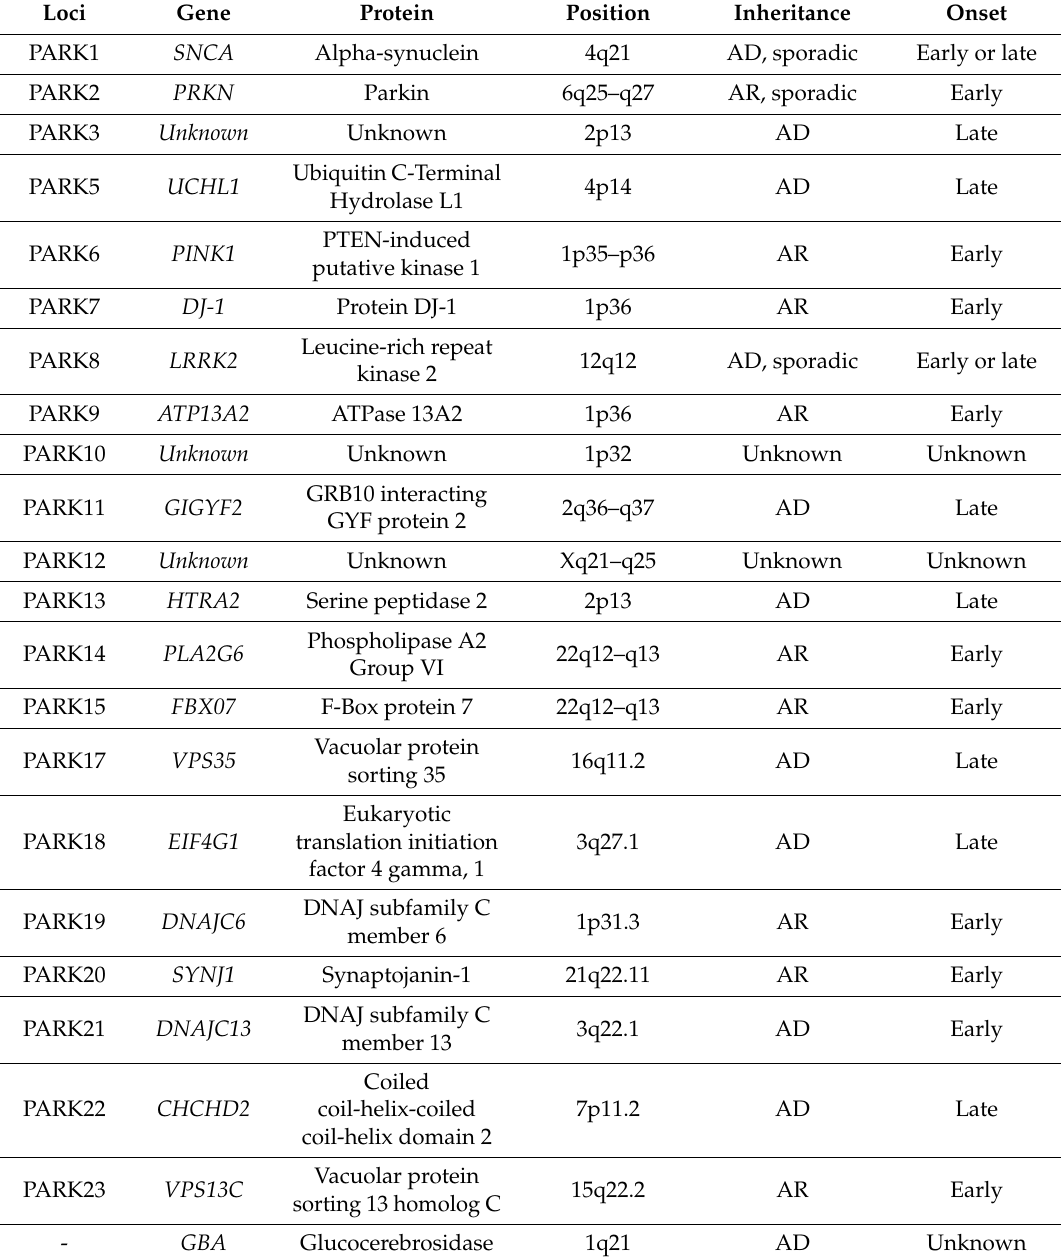
Table 1. Overview of Parkinson’s disease (PD)-related genes. Genes related to PD pathogenesis are listed in Table 1. The locus of genes, hereditary properties, and the onset of disease are described. AD, autosomal dominant; AR, autosomal